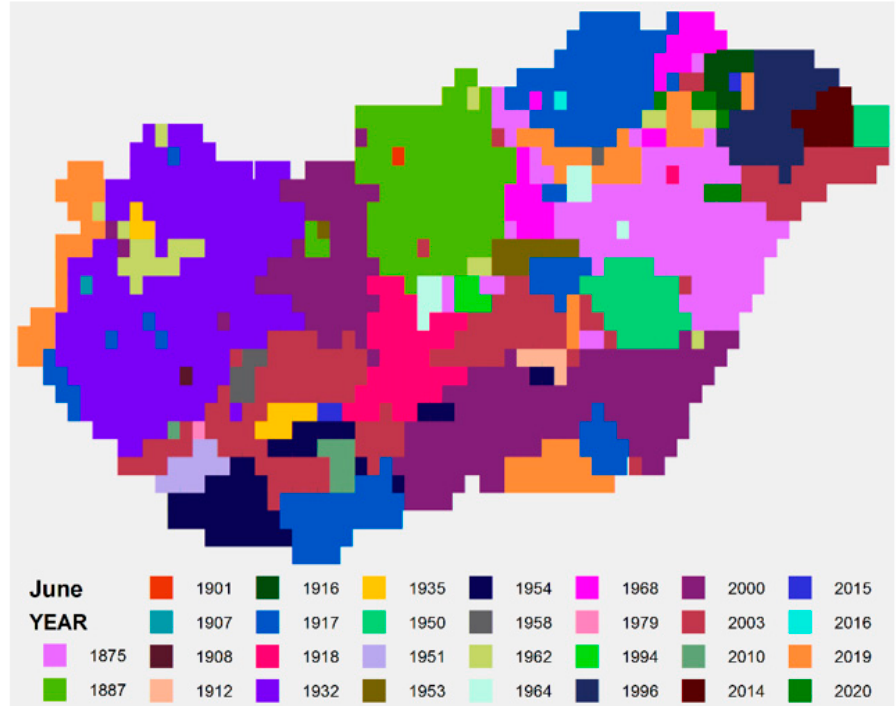
Figure A9. June: Year of maximum SPTI values, 1871–2020.